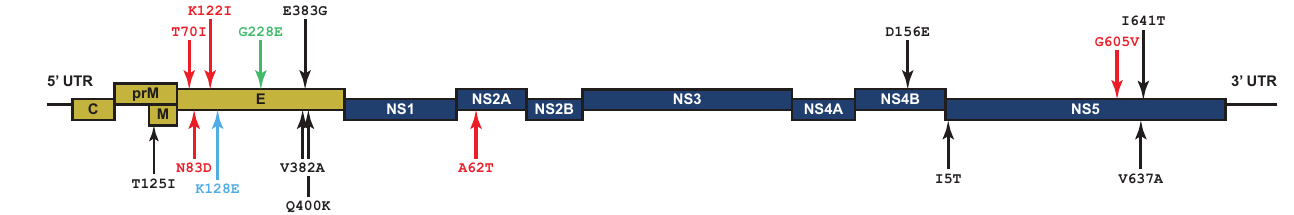
Figure 3. Mutation mapping of DENV2 strain D2S20. Red and green arrows indicate changes observed in D2S10 that are amplified in D2S20 in comparison to the DENV2 PL046; red arrows show the substitutions that occur at a frequency above 50%, while the green arrow indicates a frequency below 50%. Black arrows denote novel mutations found only in D2S20 that occur at a frequency above 1%. A blue arrow indicates a mutation that occurred at 100% frequency in both DENV2 strains D2S10 and D2S20 in comparison to the DENV2 PL046 isolate.